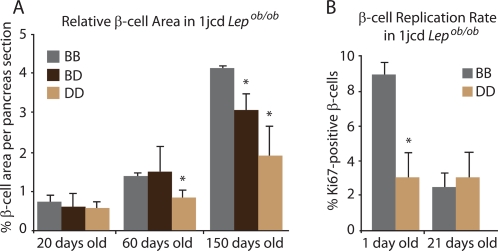
β-Cell Mass and Replication Rates in 1jcd Lepob/ob Males.A) Relative β-cell area in 20-, 60, and 150-day old Lepob/ob males segregating for B and D 1jcd congenic intervals. In 60 and 150-day old males segregating for the D/D sub-congenic interval, relative β-cell mass was approximately half that of B/B littermates; B/D animals were intermediate at 150 days. N = 10 for each of the 3 groups of animals. Mean+/−SEM. The asterisk (*) indicates that p<0.05 for D/D vs. B/B at 60 days, and D/D and B/D vs B/B at 150 days. These findings are consistent with in vivo data (see Figure 2C) showing onset of elevated blood glucose at rest and during ipGTT by 60 days. B) β-cell replication rates (Ki67) in 1- and 21-day old Lepob/ob B/B and D/D 1jcd males. To estimate the proportion of dividing cells, the number of Ki67-positive β-cells was normalized to the total number of insulin-positive cells. Replication of β-cells in 1-day old D/D males was ∼1/3 that of B/B littermates (p = 0.017). This difference, not present in 21-day old animals, was probably due to normally reduced β-cell replication by the time of weaning. Mean+/−SEM. The asterisk (*) indicates that p<0.05 for D/D vs. B/B in 1-day old animals.